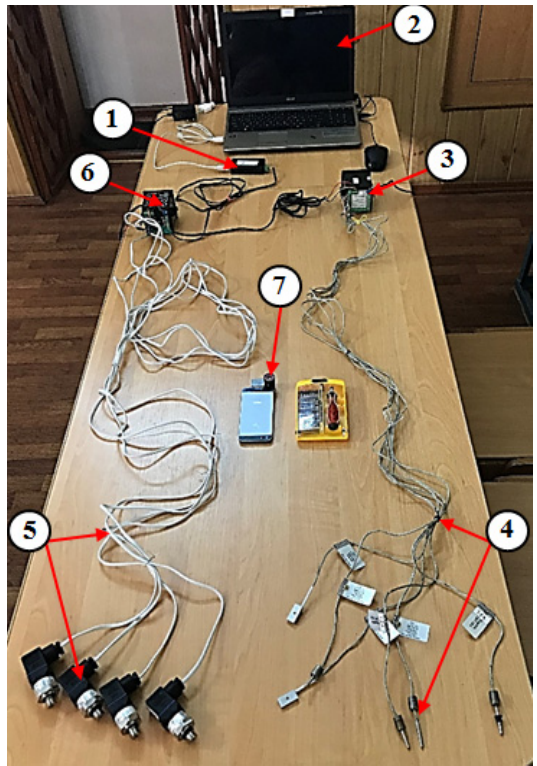
Figure 5. Information-measuring system: (1) communication interface, (2) computer with installed software interfaces, (3) eight-channel temperature meter, (4) temperature sensors, (5) pressure sensors, (6) eight-channel pressure meter and (7) thermal imaging camera.